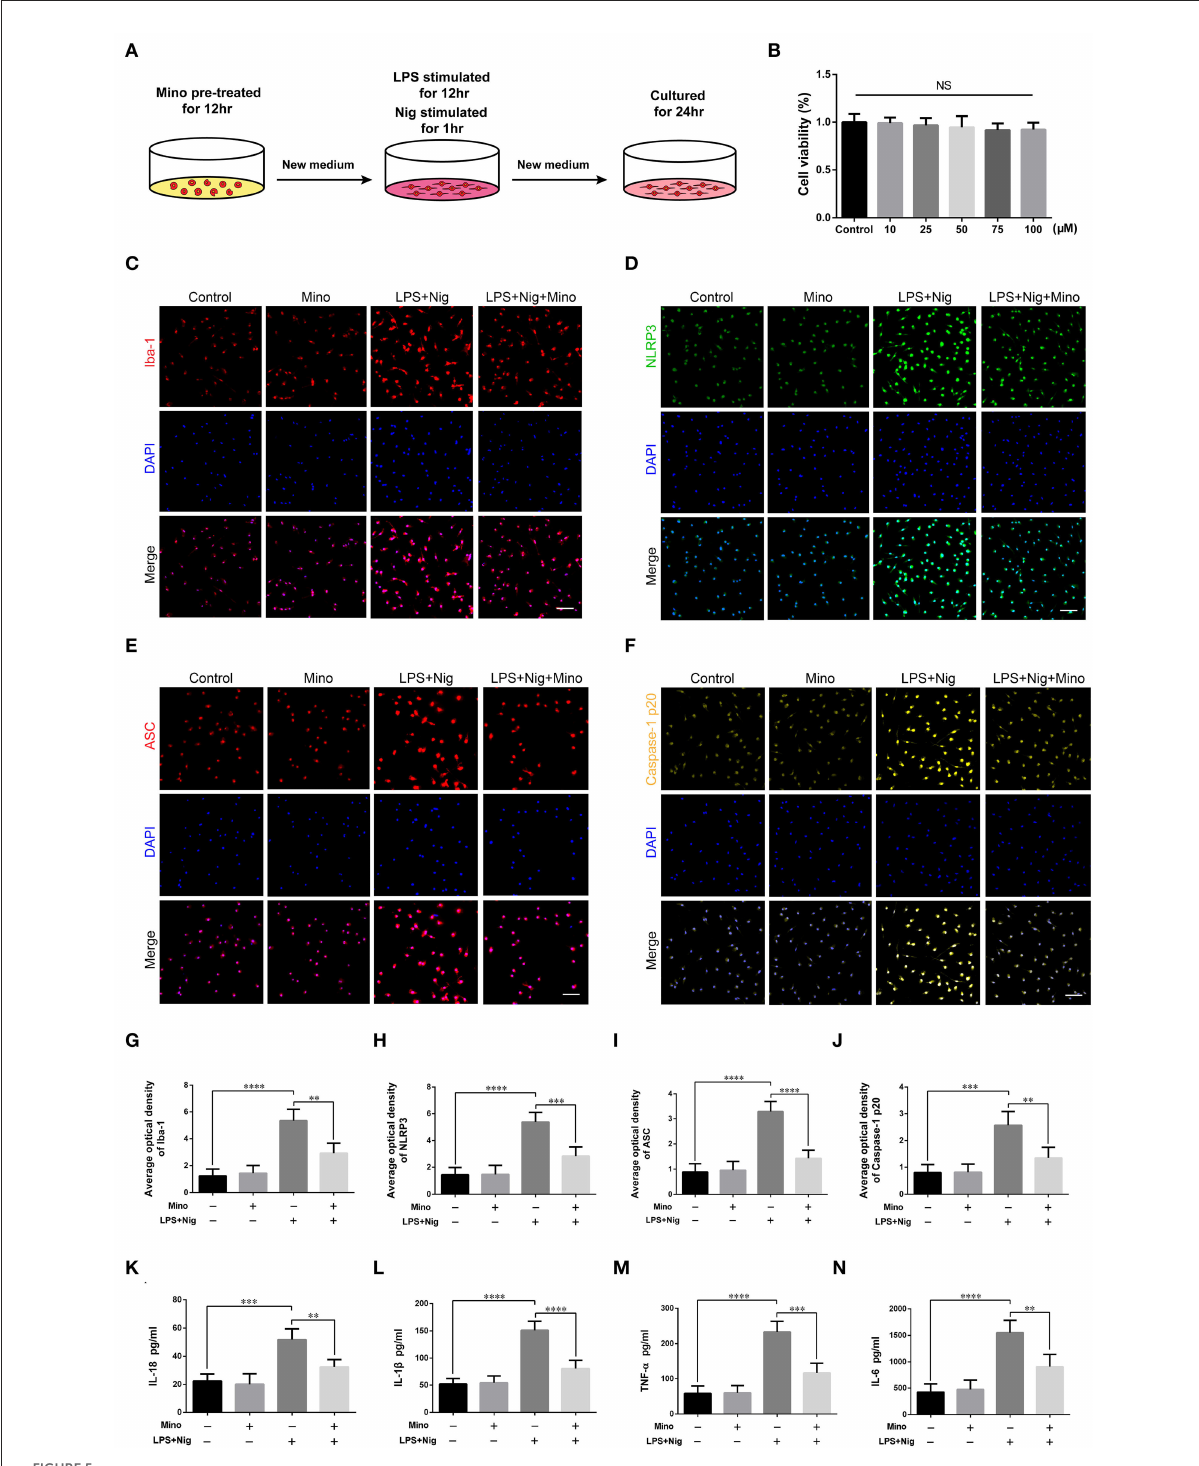
FIGURE5 Lipopolysaccharide (LPS) and Nig induced activation of primary cortical microglia simulated NLRP3-related inflammatory environment in vitro . (A) Experimental protocols related to primary microglia. (B) The viability of primary microglia was assessed at different doses of minocycline. (C–F) Representative images of Iba-1, NLRP3, ASC, and caspase-1 p20 immunofluorescence in the primary microglia of each group. Scale bars = 50 µ m. (G–J) The average optical densities of Iba-1, NLRP3, ASC, and caspase-1 p20. (K–N) Assessment of the levels of IL-18, IL-1 β , TNF- α , and IL-6 secretion in primary microglia-conditioned medium using enzyme-linked immunosorbent assay (ELISA) [data are presented as means ± SD, n = 3 for cholecystokinin (CCK), n = 4 for immunofluorescence and ELISA assays; NS: p > 0.05, ** p < 0.01, *** p < 0.001, **** p <